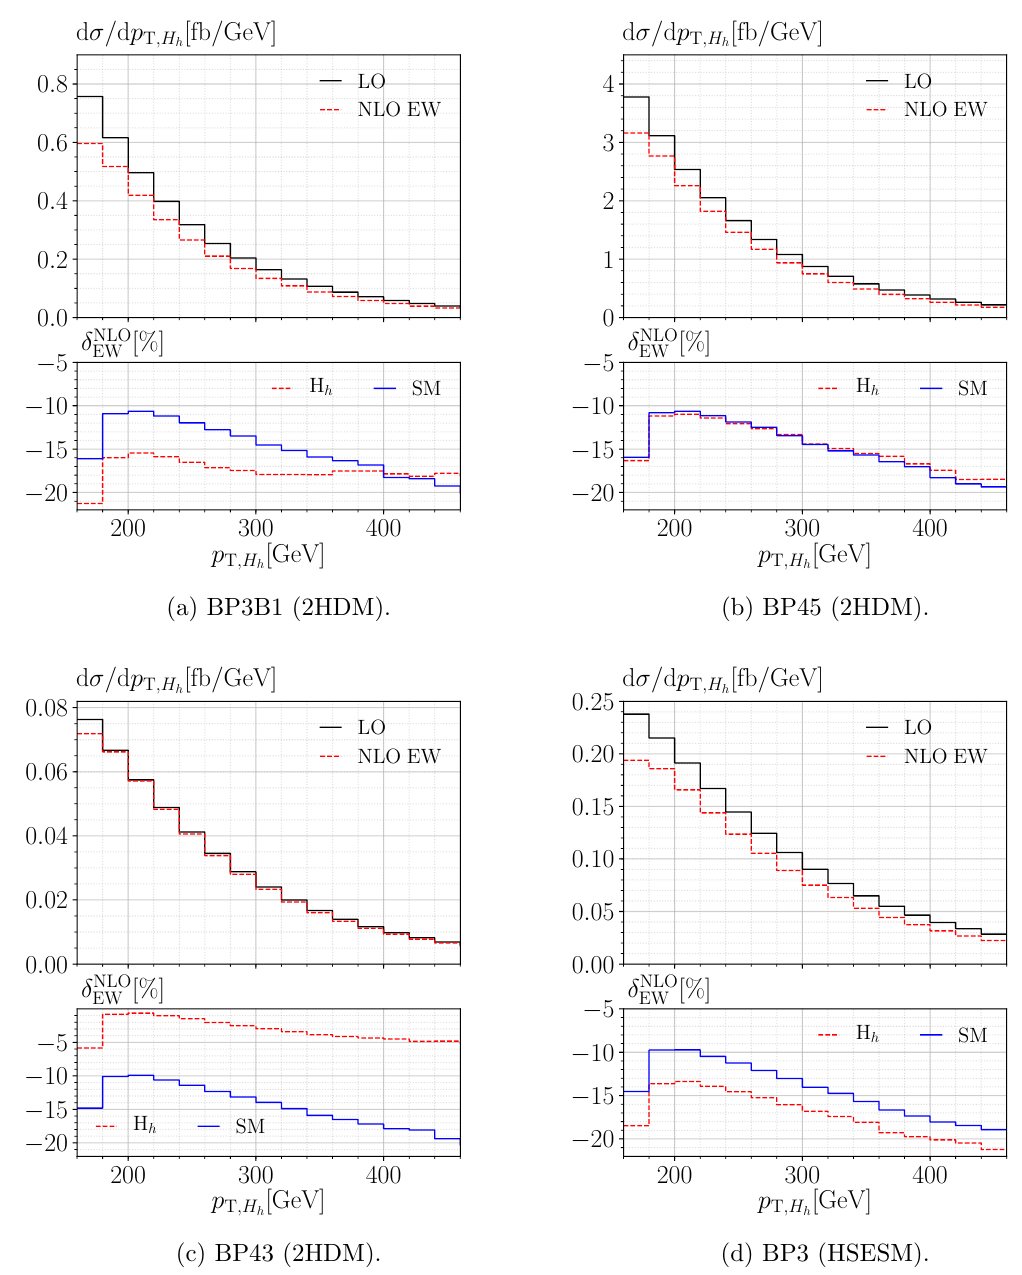
Figure 3. Distributions in the transverse momentum of the Higgs boson p production in Higgs strahlung for the benchmark points BP3B1 in (a), BP45 in (b) and BP43 in (c) in the 2HDM, and BP3 in (d) in the